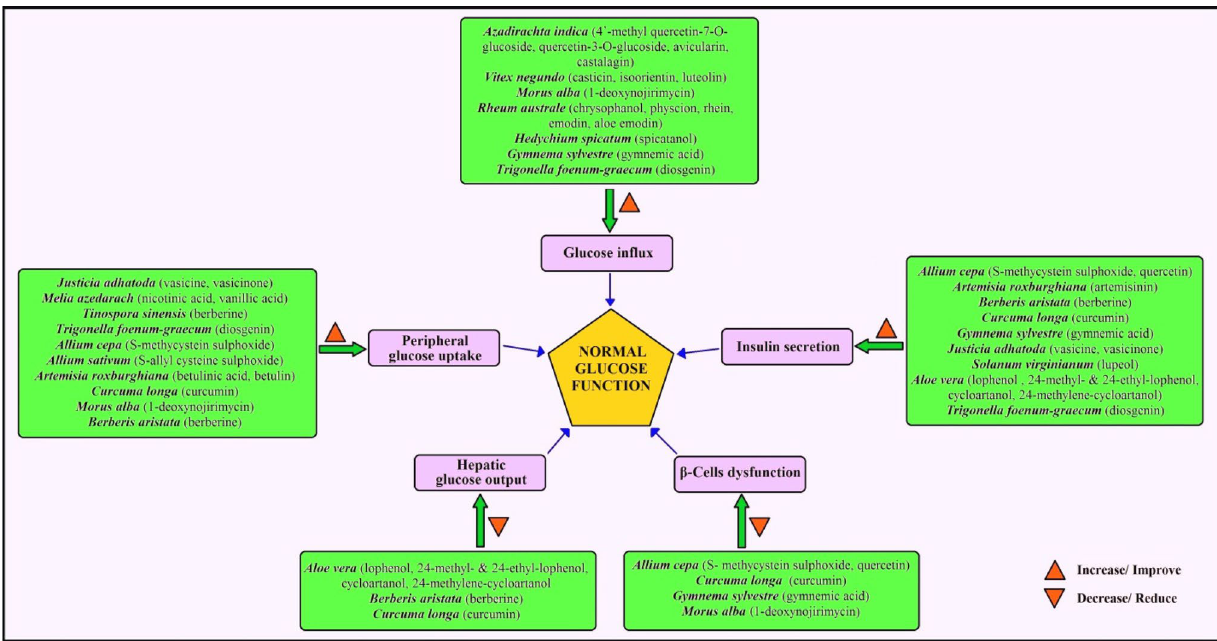
Fig. 3 Schematic diagram showing antidiabetic mechanisms of selected surveyed plants and their